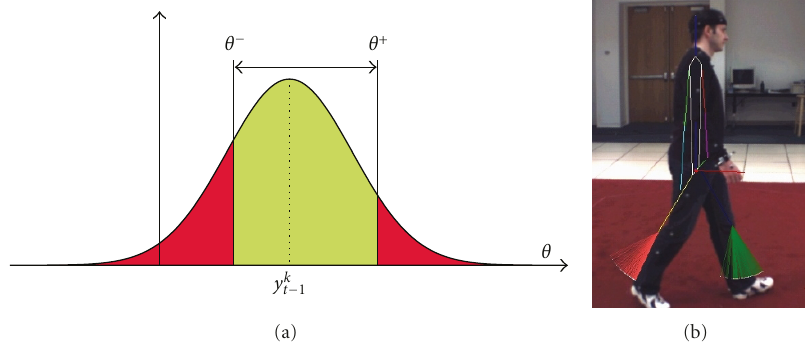
Figure 4: Angular constraints enforcement by propagating particles within the allowed angular ranges [ θ − , θ + ]. In (a), samples are propagated following a truncated Gaussian distribution N (cid:2) centered at y (green zone). (b) An example of particle propagation in the knee angle displaying how propagated particles never fall out the legal ranges ( θ < 0).